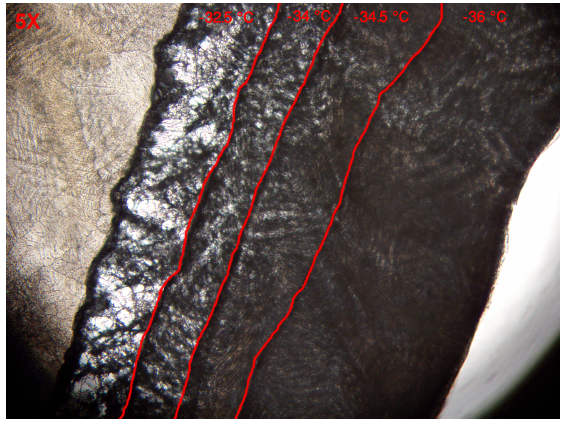
Figure 4. Overlay of images from the freeze-dry microscope at different temperatures. The red lines depicts the different temperature stages. Sublimation front moves from the right to the left side of the